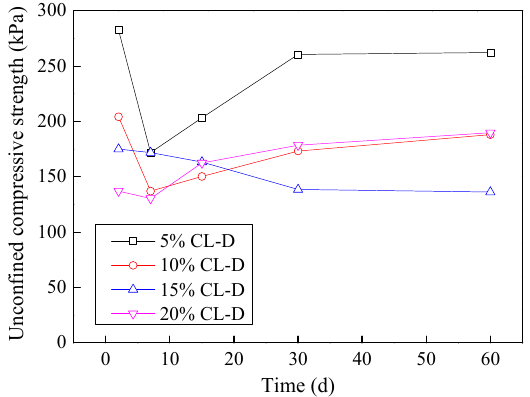
Figure 14. Effects of dyeing effluent on the cohesion of CL soil samples. Processes 2018 , 6 , x FOR PEER REVIEW